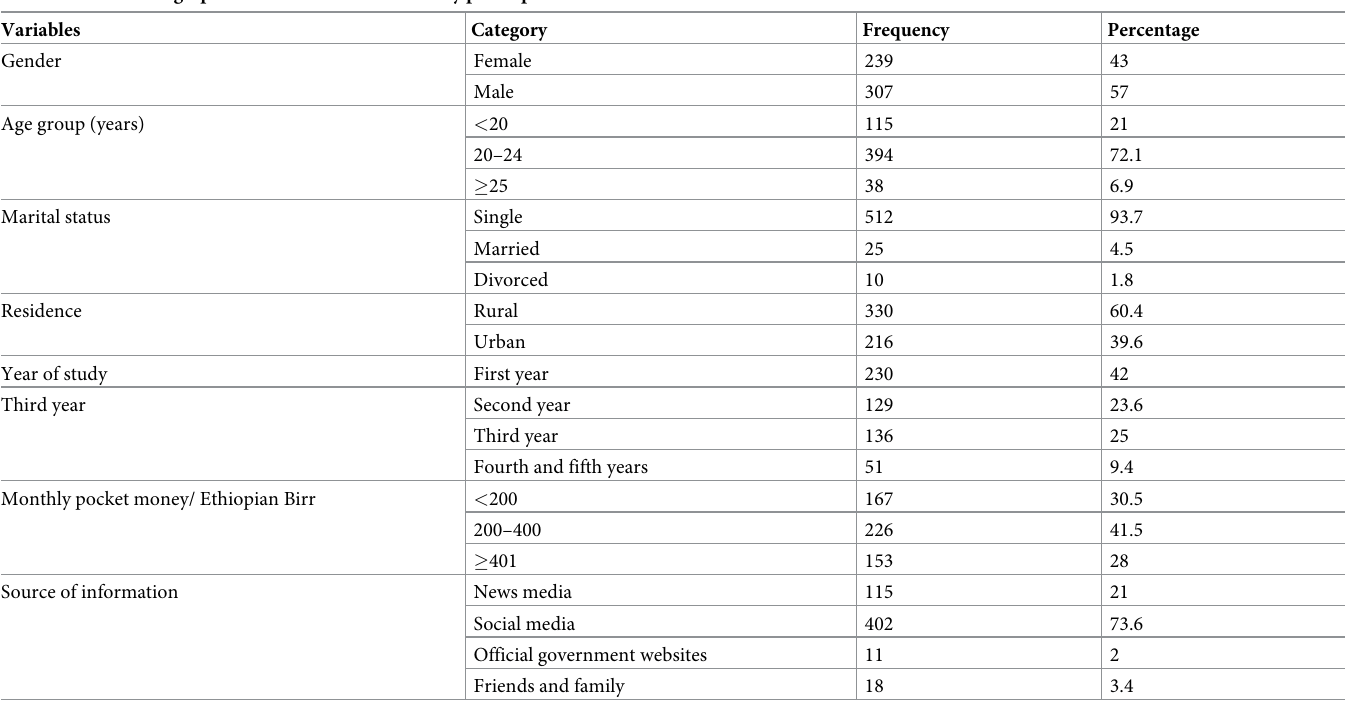
Table 1. Socio-demographic characteristics of the study